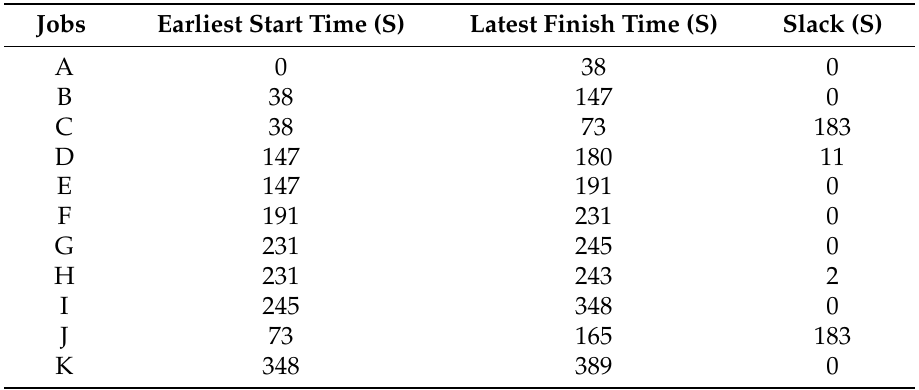
Table 3. Attributes of first